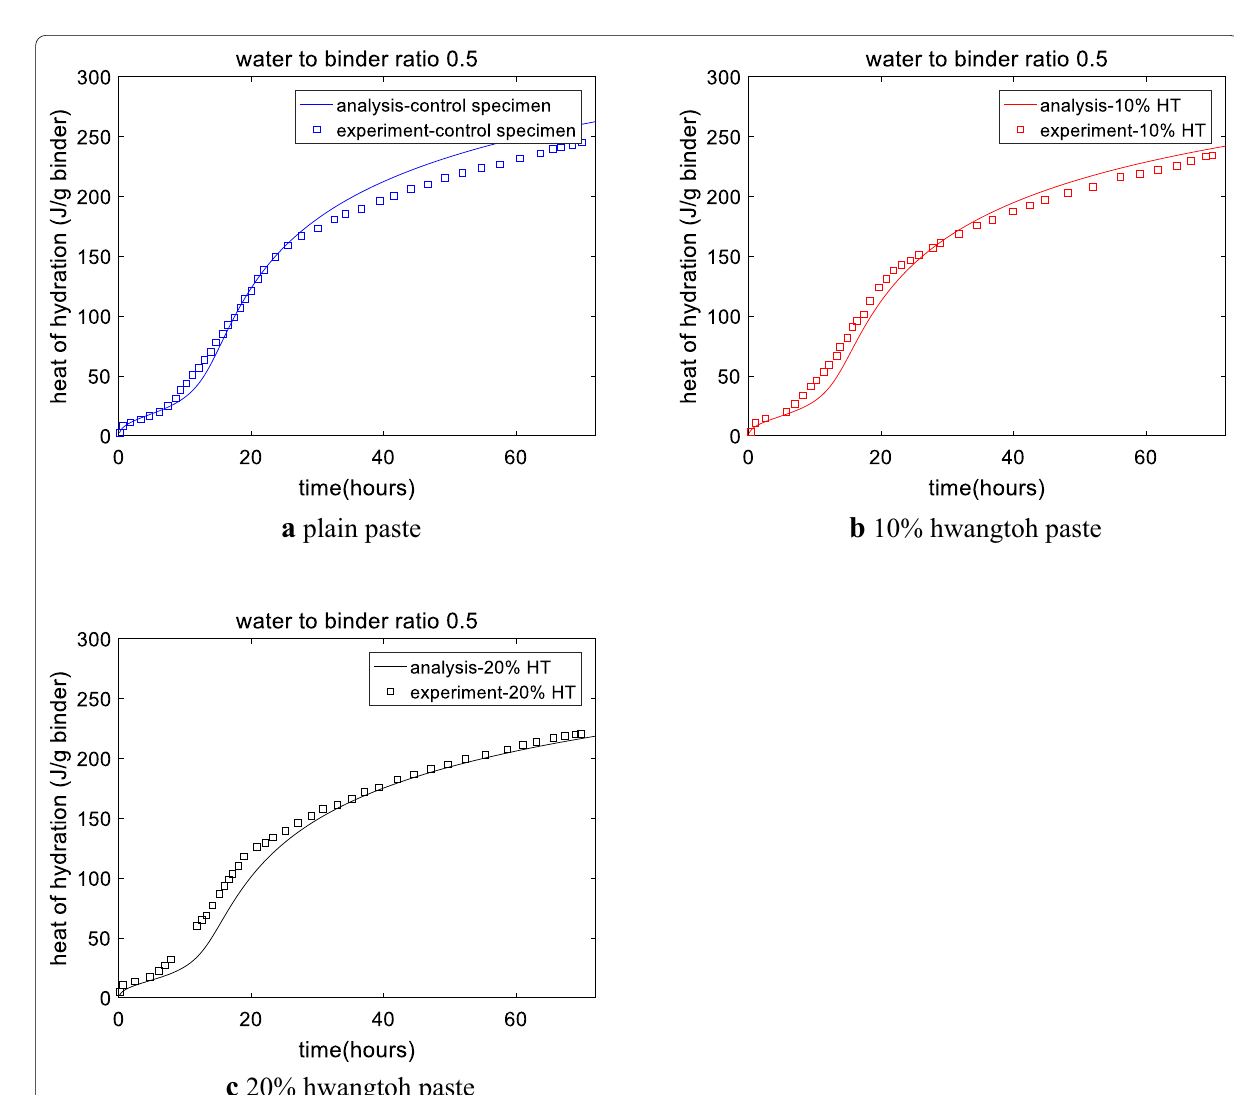
(See figure on next page.) Fig. 7 Strength development of cement–hwangtoh blends (Lin et al.